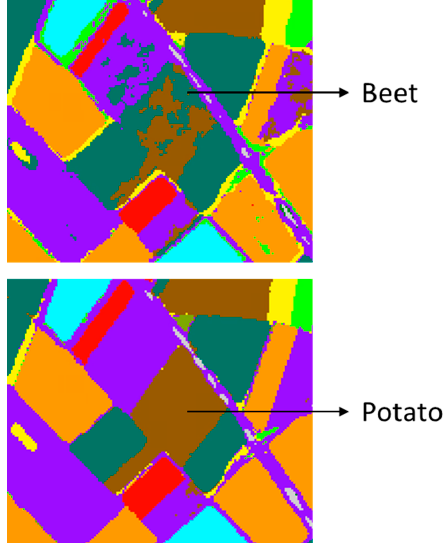
Figure 6. The combined Sentinel-1 and -2 classification result of June ( upper panel ) shows more within-field variability than the classification result of August ( lower panel ). In this particular example, the zones in the center field that were wrongly classified as beet in June but were correctly classified as potato in August.